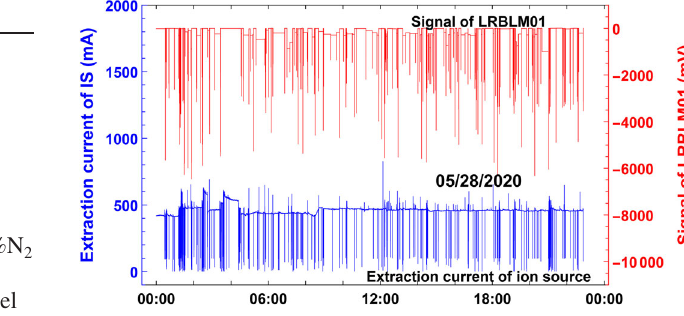
FIG. 4. A BLM signal versus the synchronous extraction- current signal of the ion